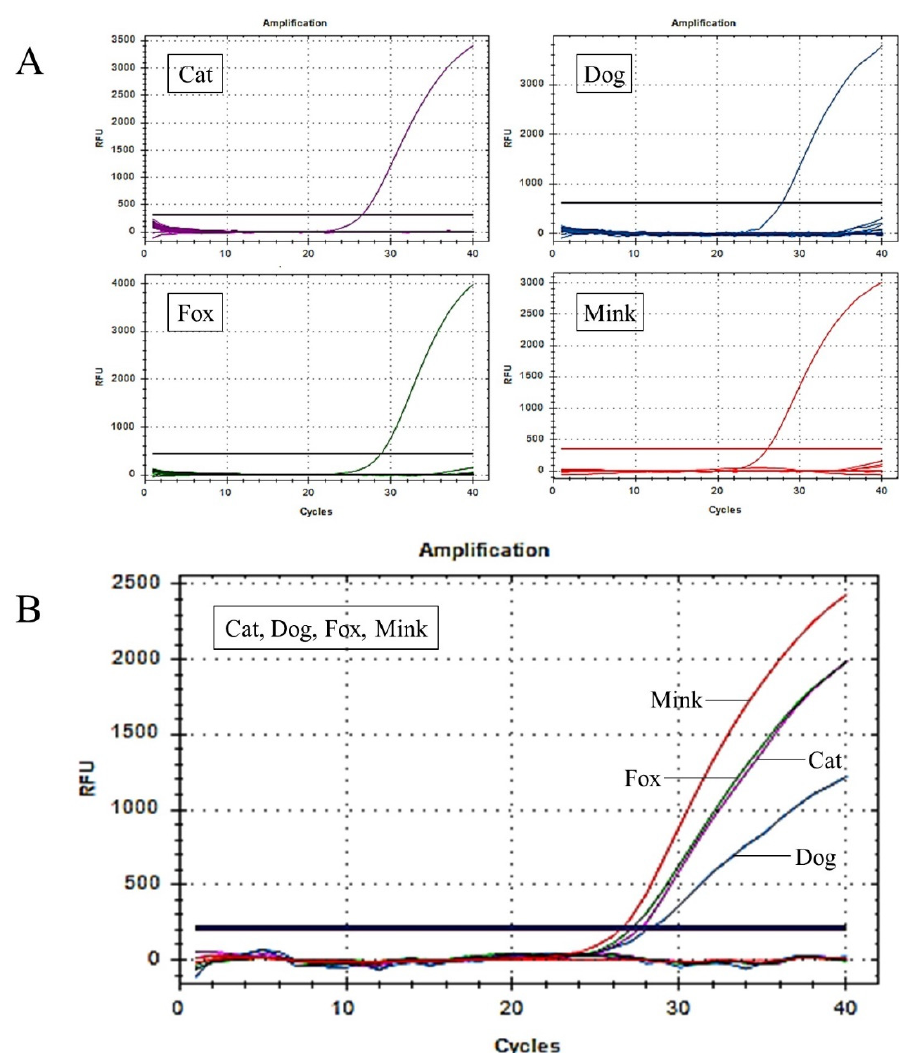
Figure 3. Establishment and optimisation of the UP-M-rtPCR system. ( A ) Specificity analysis of the UP-M-rtPCR system in 21 animal species. ( B ) Simultaneous detection of cat, dog, fox, and mink DNA in a single reaction using UP-M-rtPCR.